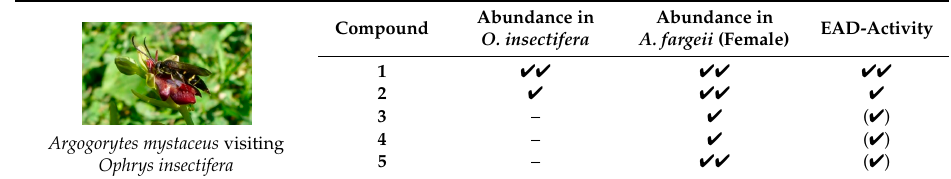
$$$$ Argogorytes mystaceus visiting ✔✔ = very abundant compound (>20% of base peak area); repeated (6 extracts, >6 synthetic samples) strong EAD-responses. ✔ = abundant compound (>10% of base peak area); repeated EAD-responses (2 extracts, >6 synthetic samples). ( ✔ ) = occasional weaker EAD-response (generally less than 50% of response of orchid semiochemicals, >3 synthetic samples). Photo A.M. Weinstein.